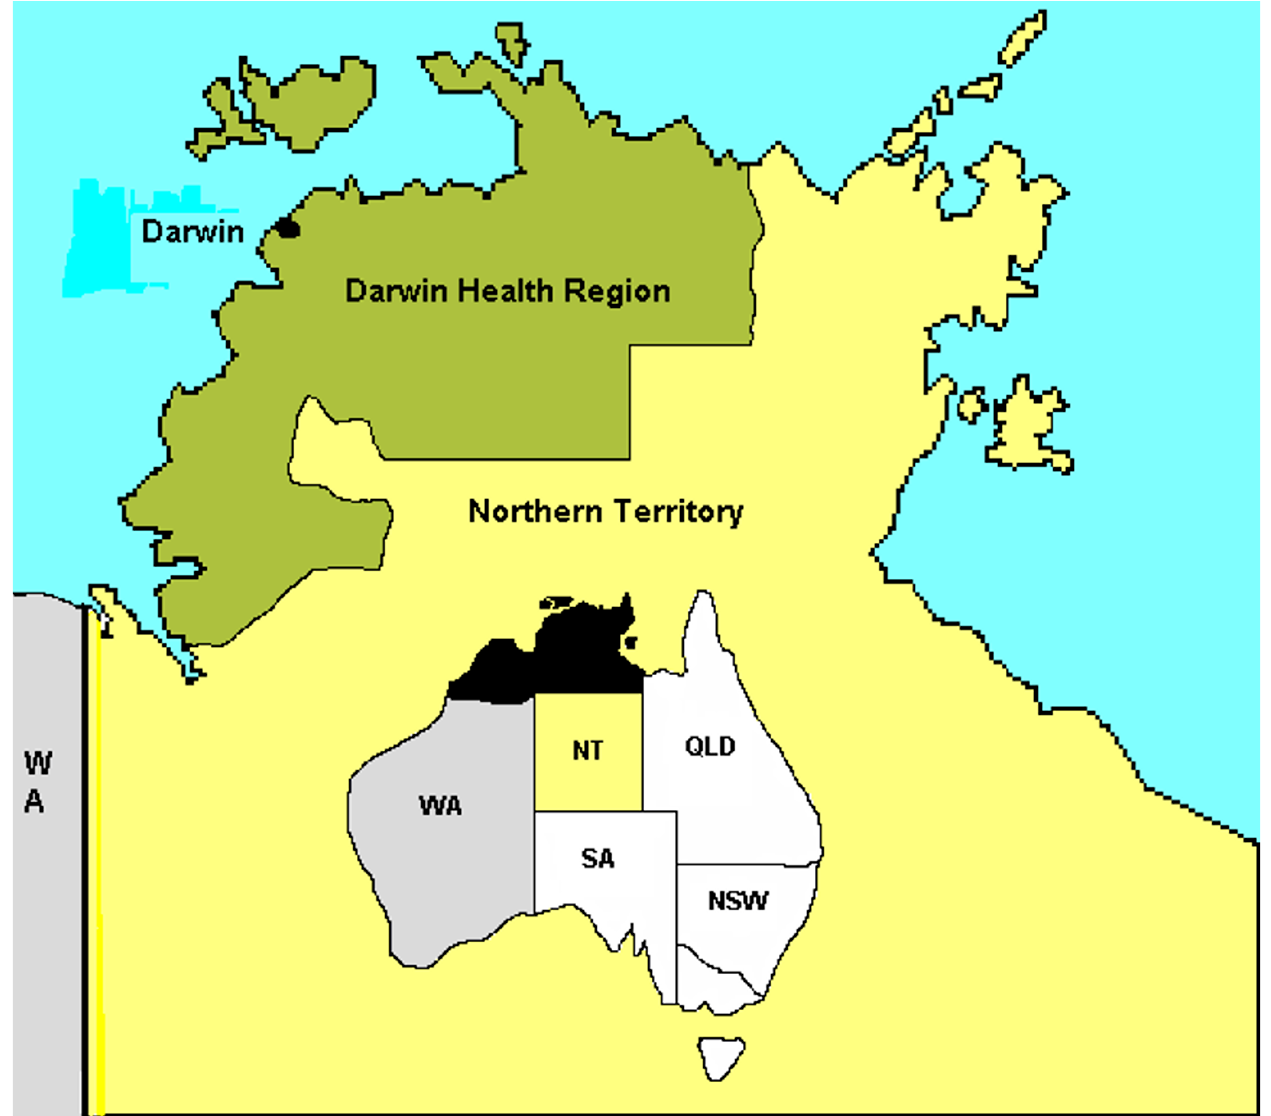
Northern Territory map with Darwin Health Region and Australia insert with area for referrals to the tertiary centre . Darwin: Situation of the Royal Darwin Hospital receiving all admissions from the Darwin Health Region (green in Northern Territory map) and high risk referrals from adjacent health regions in the Northern Territory and Western Austral- ian (black on the Australian